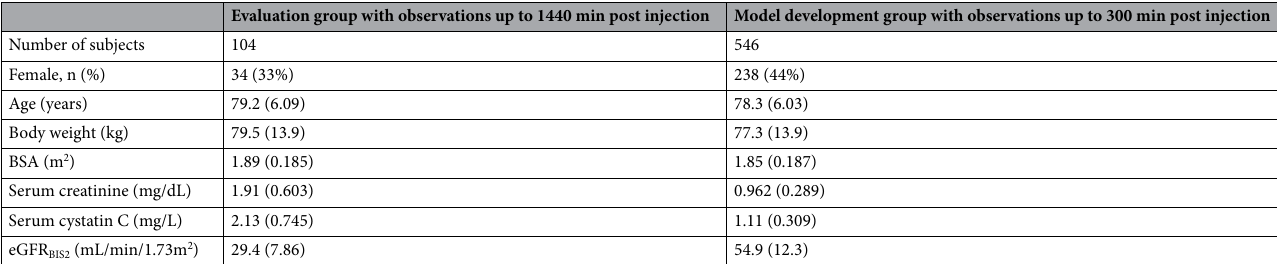
Table 1. Characteristics (mean [standard deviation] or absolute frequency [%]) of the study population compared to the previously investigated study population with only 300 min of iohexol sampling time. The population pharmacokinetic models were developed in a study population of n = 546 (model development group) and validated in a study population with iohexol sampling up to 1440 min (n = 104, evaluation group). eGFR = estimated glomerular filtration rate, BIS2 = eGFR equation from the Berlin Initiative Study based on serum creatinine and cystatin C. Body surface area (BSA) based on the Du Bois & Du Bois equation 0.725 ∗ weight 0.425 ( BSA = 0.20247 ∗ height ).